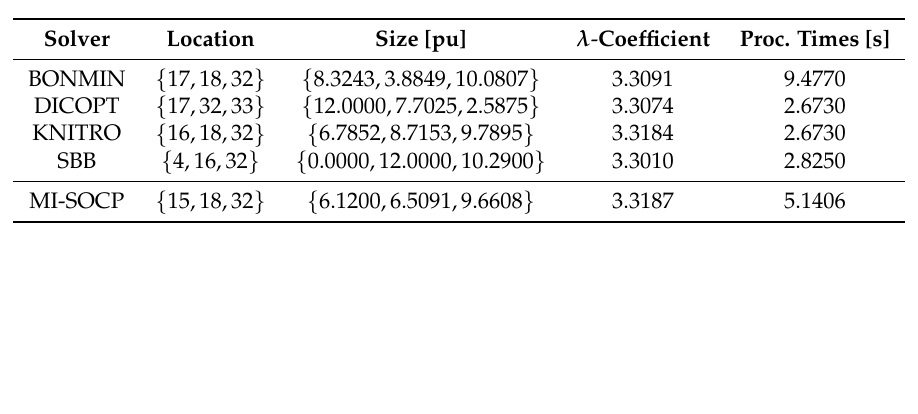
Table 6. Comparisons between the MINLP solvers in GAMS and the MI-SOCP